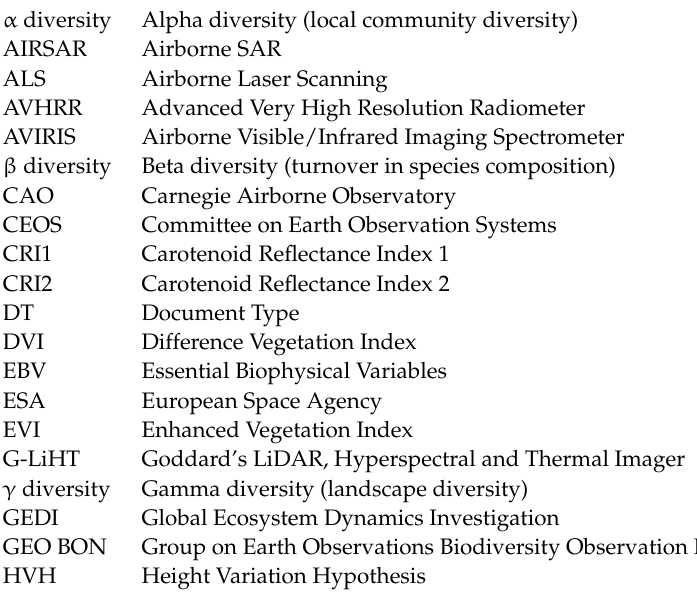
Table S2: Reclassification Code of Web of Science